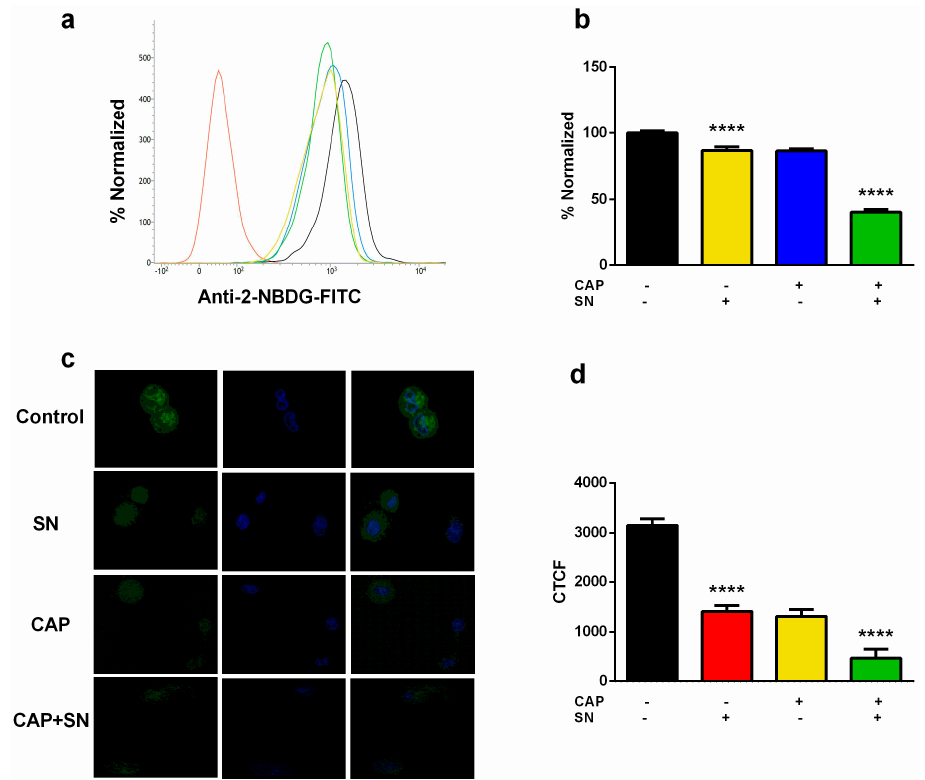
Figure 3. Estimation of intracellular glucose (ATP level) using fluorescent glucose analog 2-NBDG ( a ) employing flow cytometry in a bar graph; ( b ) calculated values in terms of the bar graph; ( c ) images were taken using confocal microscopy (intensity of green color represents the presence of glucose and blue indicates the nucleus); ( d ) captured images were expressed terms of Corrected Total Cell Fluorescence (CTCF) in a bar graph